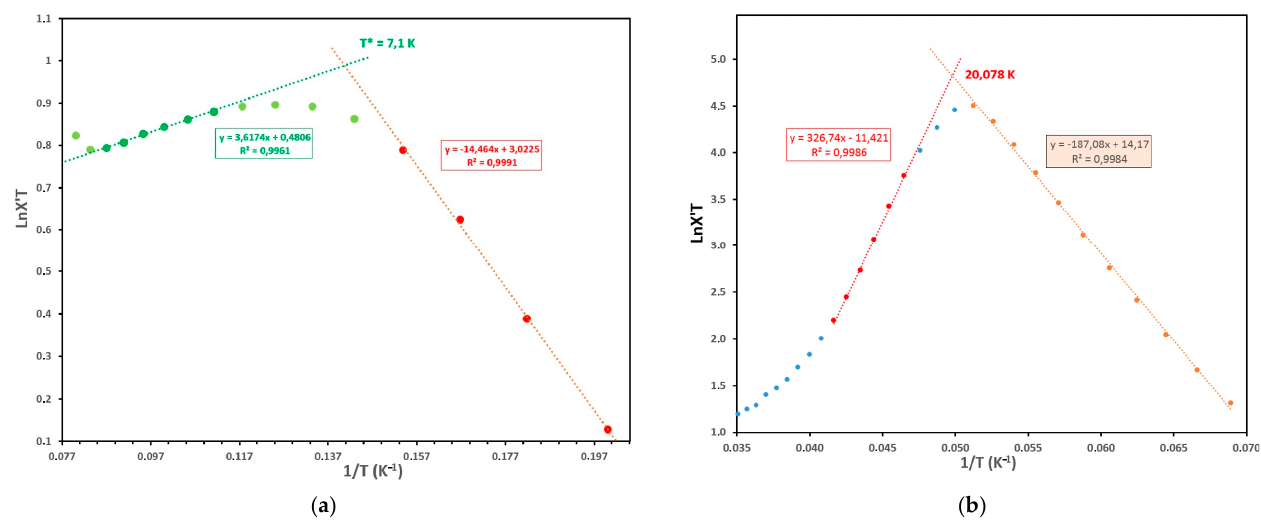
Figure 26. Plots of ln( χ′ T ) vs. 1/ T , where χ′ is a real component of the ac susceptibility collected in the applied dc field of 100 Oe, with H ac = 3 Oe, and a frequency of 0.56 Hz; ( a ) for 14; ( b ) for 13 [56].